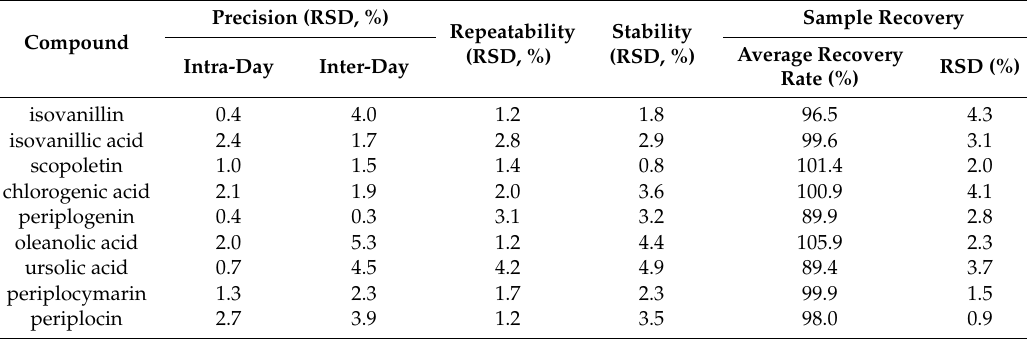
Table 3. Precision, repeatability, stability, and recovery of nine